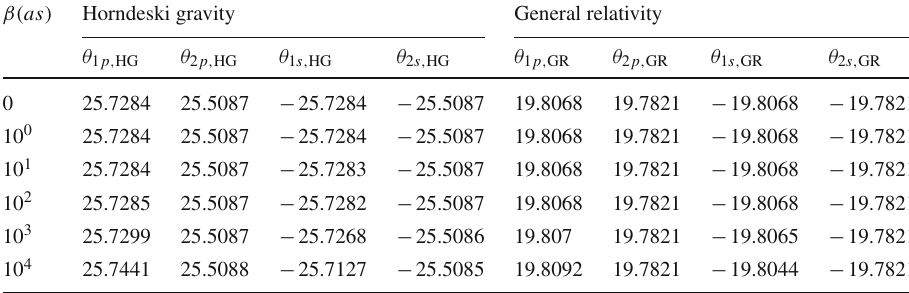
Table 4 Image positions of first and second order primary and secondary images due to lensing by Sgr A* with d = D LS / D OS = 0 . 5: GR and Horndeski Gravity ( q = − 0 . 5 ) predictions for angular positions θ of primary ( p ) and secondary images ( s ) are given for different values of angular source position β . (a) All values of θ are in μ as . (b) We have